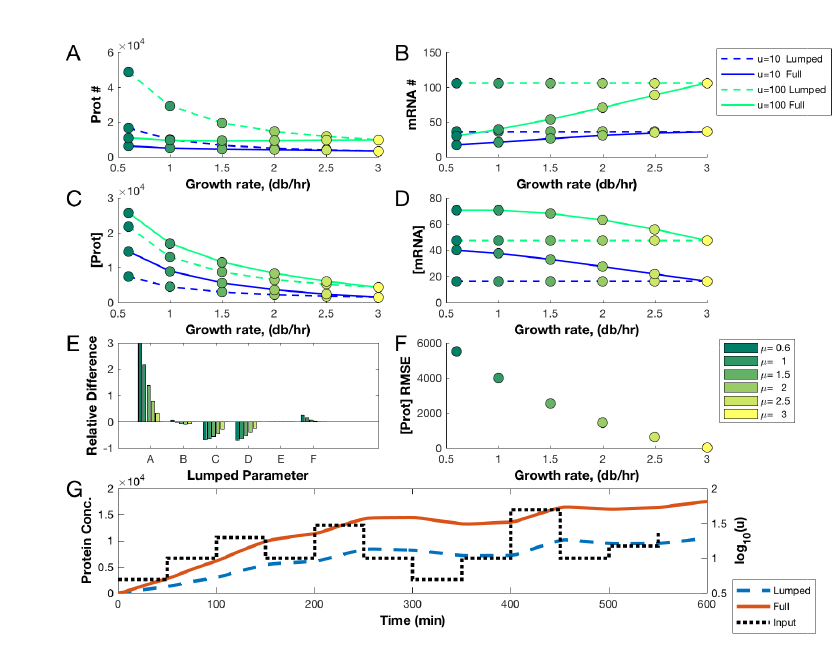
Figure 2. ( A , B ) Steady state protein (A) and mRNA (B) copy number predictions for the lumped and full model across growth rate for two different constant input levels. ( C , D ) Corresponding protein (C) and mRNA (D) concentrations. ( E ) Relative difference in the lumped parameter values, fit at 3 db/h, compared with the values predicted by the full growth dependent model. ( F ) Root mean squared protein concentration error over the dynamic simulation (G) between the full and lumped model. ( G ) Predicted protein concentrations of the lumped and full model over a dynamic simulation with a growth rate of 0.5